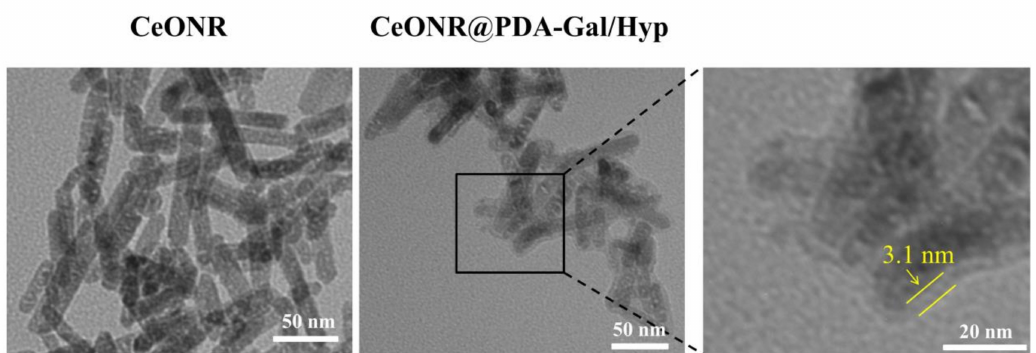
Figure 1. TEM images of CeONR and CeONR@PDA-Gal / Hyp nanorods (Scale bar: 50 nm for the right and middle images as well as 20 nm for the left